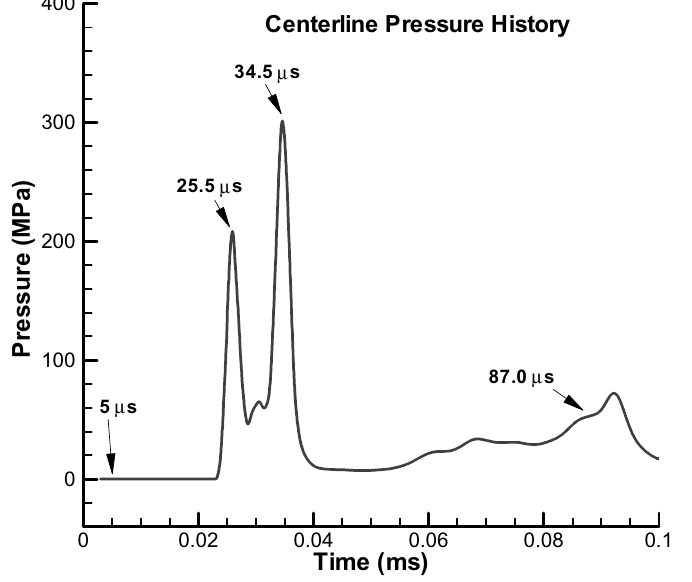
Fig. 11. Centerline pressure water first meet at the center of the